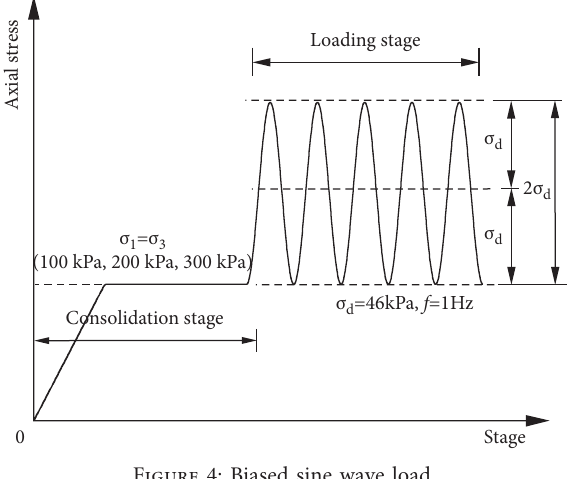
Figure 4: Biased sine wave